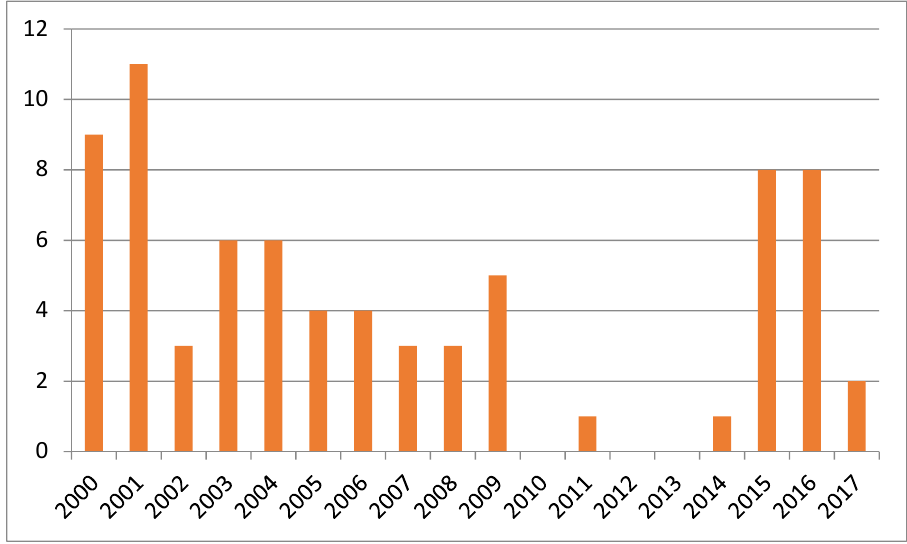
Figure 1. Terror attacks in Eurozone countries over the period 2000–2017. Notes: the above chart depicts a chronological breakdown of the 63 event days, which comprise our sample.